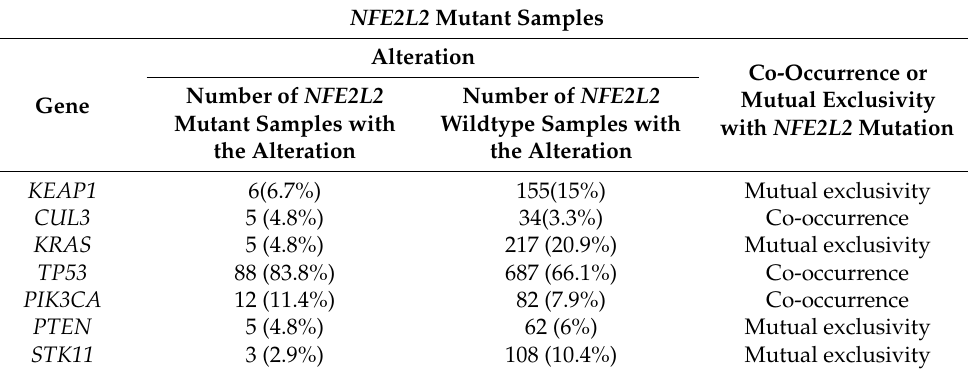
Table 5. NFE2L2 mutations occur alongside mutations in other genes in NSCLC *.